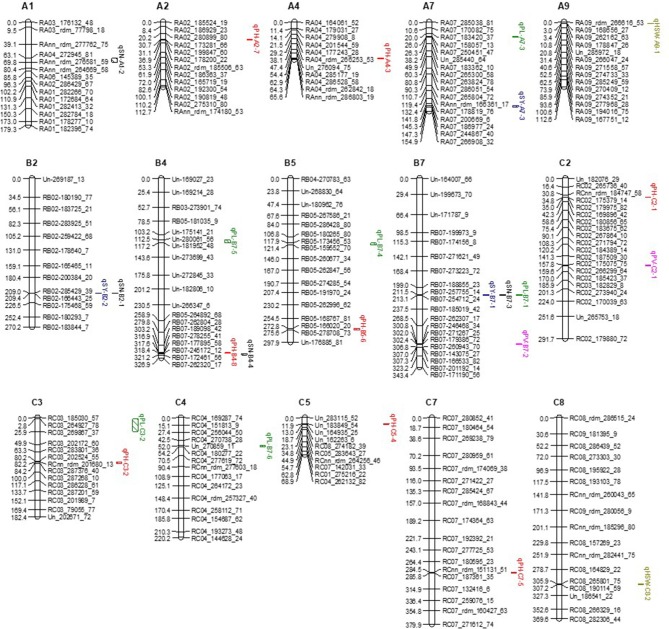
Additive QTL identified for 6 phenotypic traits including seed number, seed yield, pod length, plant height, 1000-seed weight and pollen viability using ICIM method of QTL IciMapping 4.1 on a doubled haploid mapping population derived from allohexaploid Brassica hybrid H16-1. QTL for seed number, seed yield, pod length, plant height, 1000-seed weight and pollen viability are black, blue, green, red, brown and pink, respectively.